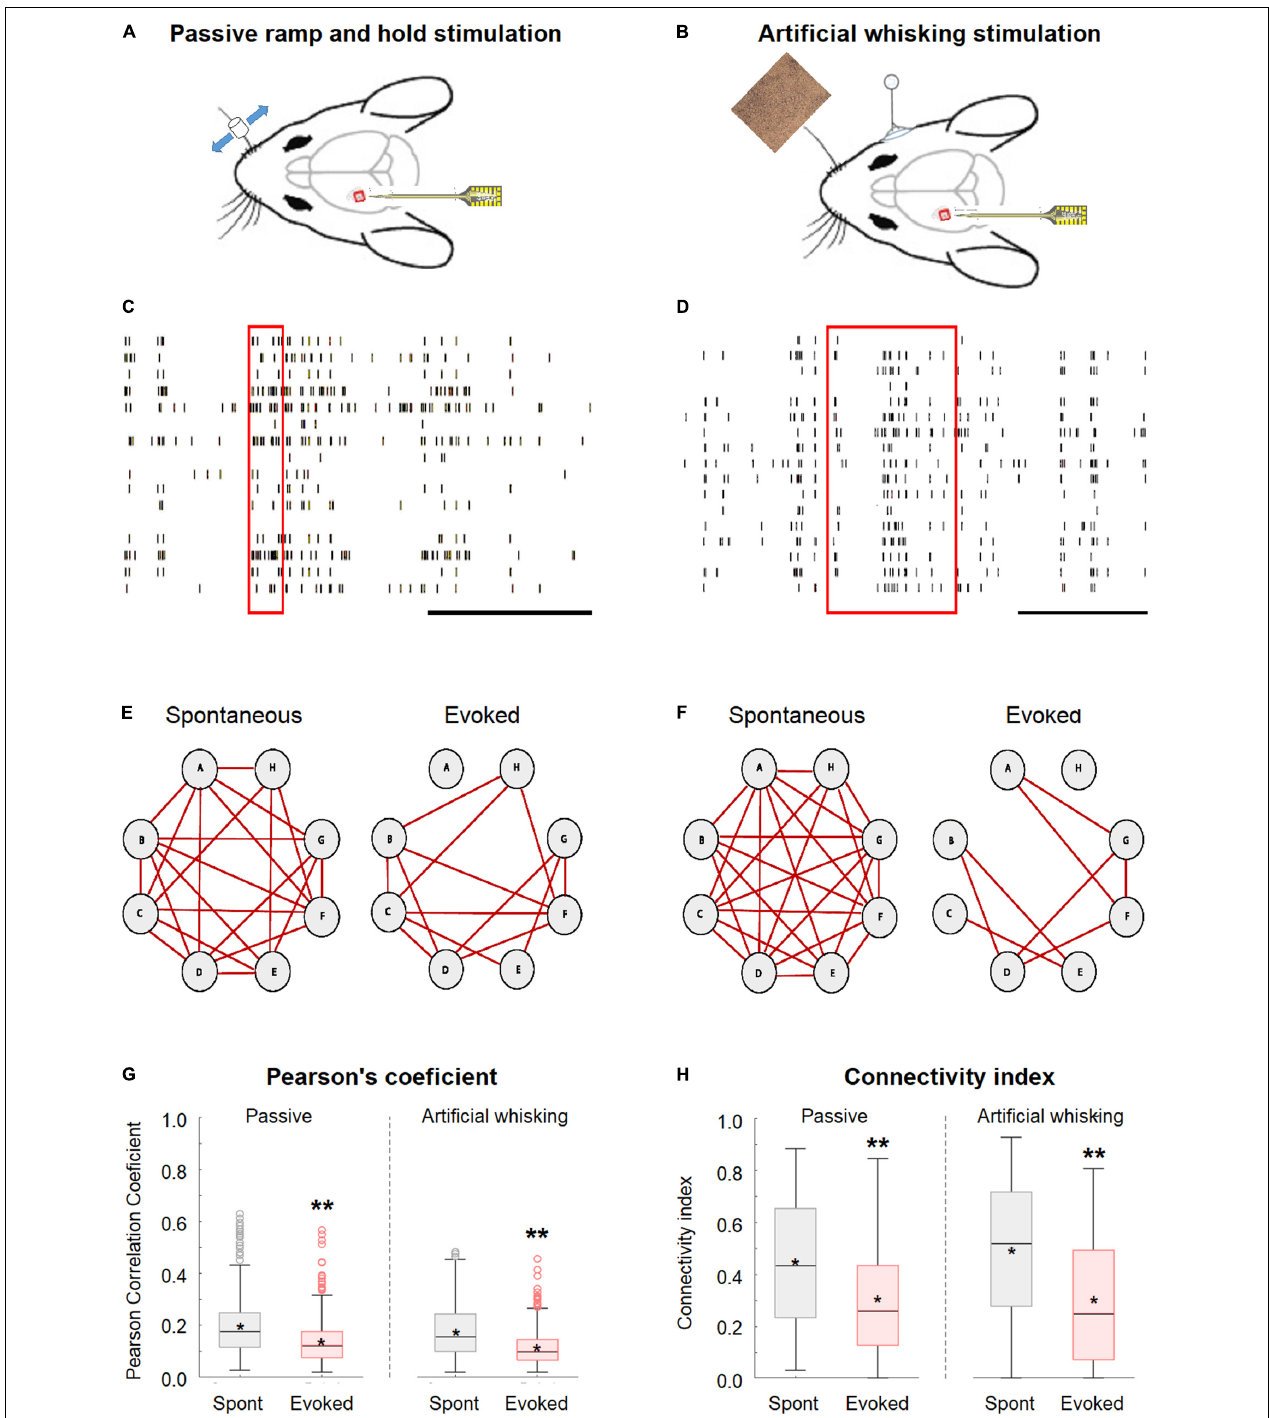
FIGURE 1 | Desynchronization during evoked activity in the primary barrel vWS1 somatosensory cortex. (A,B) Scheme of the experimental design with the recording electrode in wS1 and the principal whisker is activated either with ramp-and-hold passive vibrissa deflection (A) , or artificial whisking stimulus against sandpaper (B) . The mouse was adapted from SciDraw caricatures (doi.org/10.5281/zenodo.3925903). (C,D) Examples of the raw spike train recorded during the passive ramp-and-hold whisker deflection (C) and artificial whisking against sandpaper (D) . The red rectangles represent the time of stimulation, while the black scale bar at the lower right corners represents 1 s. (E,F) Individual examples of connectivity diagrams of eight-layer 2-3 neurons during spontaneous pre-stimulation (left) and evoked activity (right) in the passive ramp-and-hold whisker deflection (E) and artificial whisking against sandpaper (F) . The red lines designated functionally